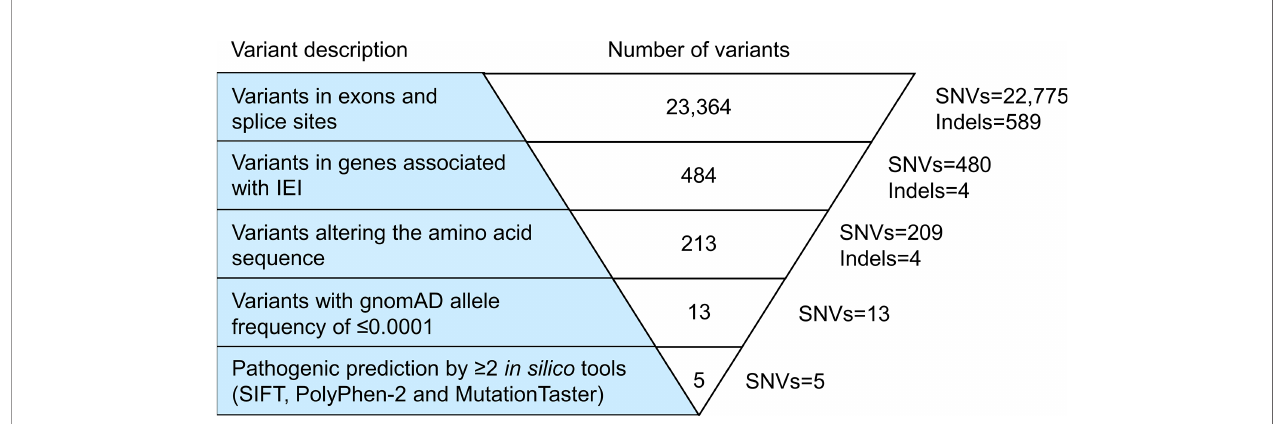
FIGURE 1 | Variant fi ltering strategy. All variants harbored in the exonic regions and splice sites were fi ltered based on the known IEI-associated genes, variant class, allele frequency and variant functional impact. Five potential causative single nucleotide variants (SNVs) ful fi lled the fi ltering criteria. However, the inheritance pattern and associated features of these genetic disorders did not match the zygosity and clinical symptoms of the patient respectively. IEI, inborn errors of immunity; SNVs, single nucleotide variants; Indels, small insertions or